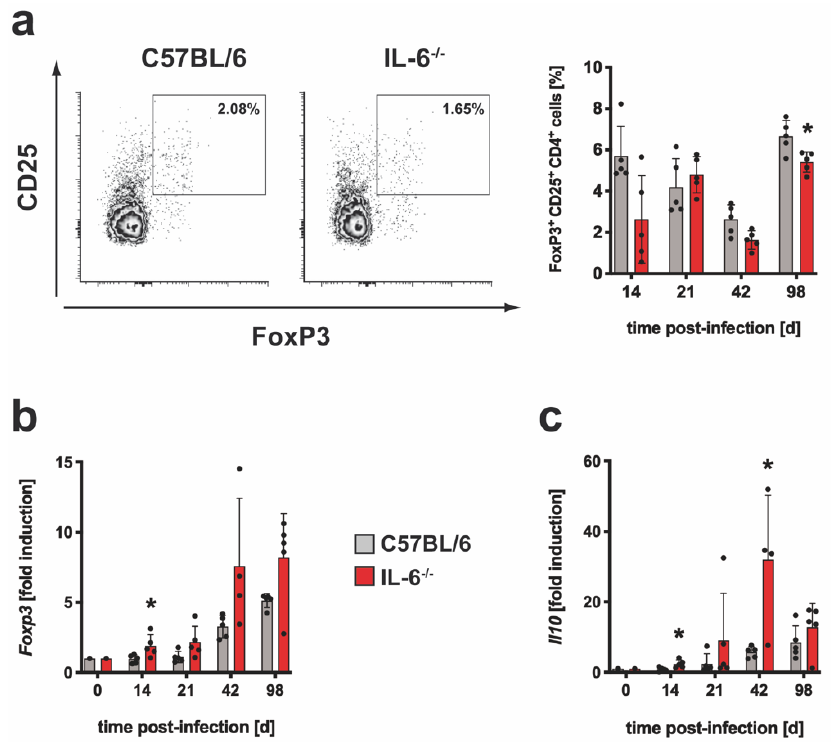
Figure 2. The regulatory immune response in Mtb-infected IL-6 − / − mice. C57BL/6 (grey symbols) and IL-6 − / − (red symbols) mice were infected with approximately 100 CFU Mtb via the aerosol route. At the indicated time points, lungs were removed and further processed. ( a ) The relative amount of the FoxP3 + CD25 + population within the CD4 + T cells was determined in single cell suspensions of lungs by flow cytometry. Representative density plots of FoxP3 + CD25 + CD4 + T cells on day 42 and frequencies of FoxP3 + CD25 + CD4 + T cells during the course of infection are shown. ( b , c ) After reverse transcription of isolated lung RNA, gene expression of ( b ) Foxp3 and ( c ) Il10 was quantified by real-time RT-PCR based on gene expression in uninfected mice. Mean values with standard deviations of 5 mice per group are shown. One representative experiment of two is shown. Data were statistically analyzed using the Mann–Whitney test defining differences between C57BL/6 and IL-6 -/- mice as significant (*, p ≤ 0.05).